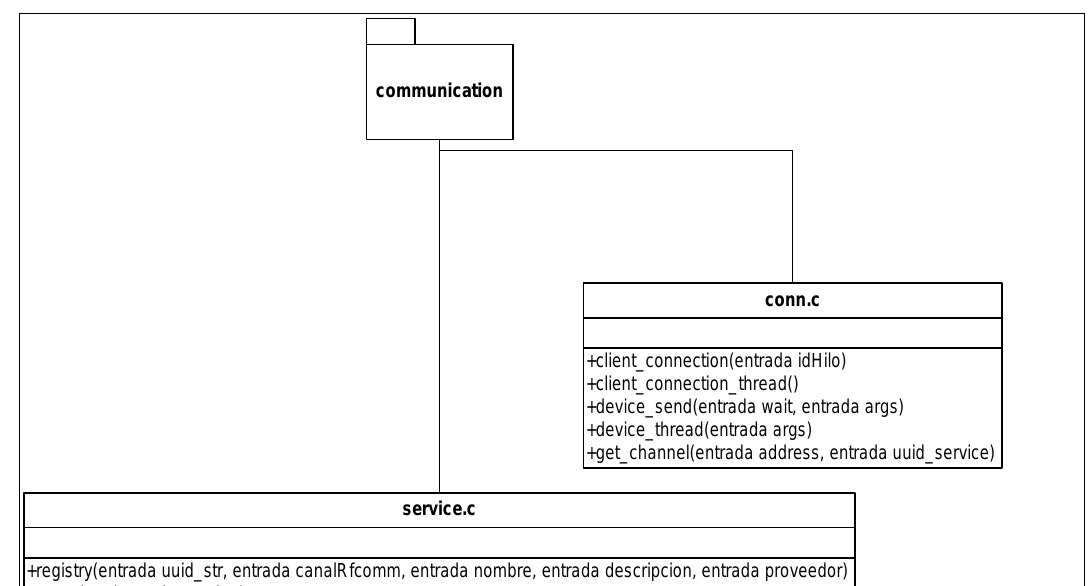
Figure 11. Class Diagram in the communication subsystem.